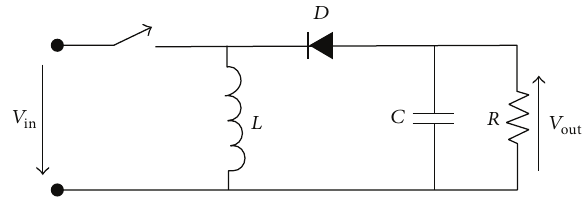
Figure 2: DC-DC buck-boost converter topology, Brey et al. [6].